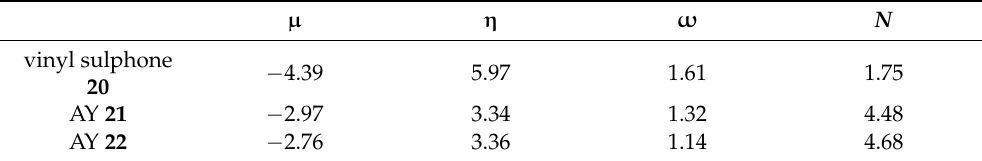
Table 1. B3LYP/6-31G(d) electronic chemical potential µ , chemical hardness η , electrophilicity ω , and nucleophilicity N indices, in eV, of AYs 21 and 22 and phenyl vinyl sulphone 20 . µ η ω N vinyl sulphone